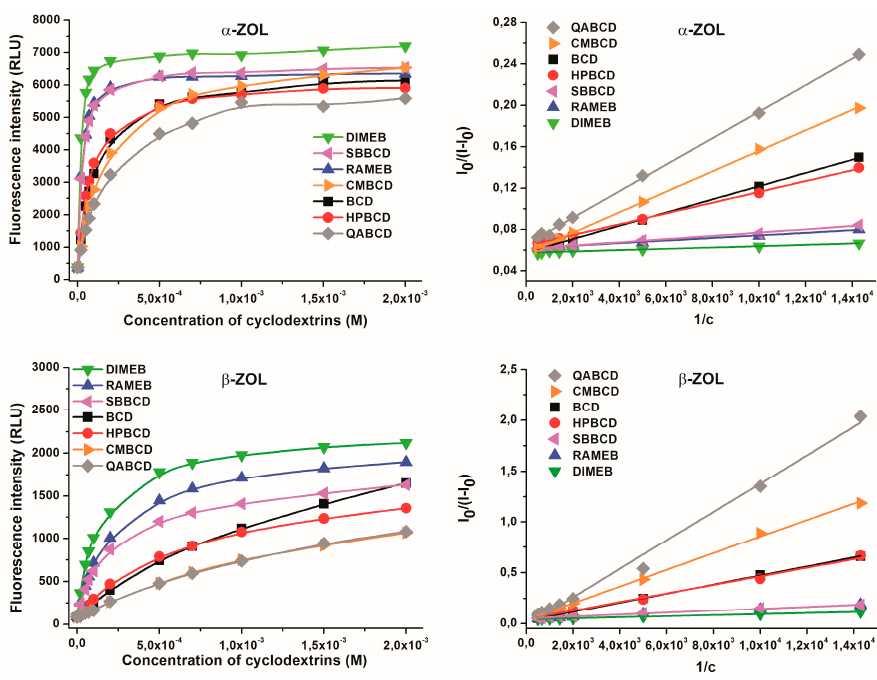
Figure 6. Fluorescence emission intensities of α -ZOL (2 μ M; top left ) and β -ZOL (2 μ M; bottom left ) in the presence of increasing CD concentrations (0–2 mM), and Benesi-Hildebrand plots of α -ZOL–CD ( top right ) and β -ZOL–CD ( bottom right ) complexes in 0.05 M sodium acetate buffer (pH 5.0; λ exc = 315 nm, λ em = 455 nm). Table 1. Decimal logarithmic values of binding constants ( K ; dm 3 /mol) of ZOL-CD complexes determined using the graphical application of Benesi-Hildebrand equation (Equation (1)) in 0.05 M